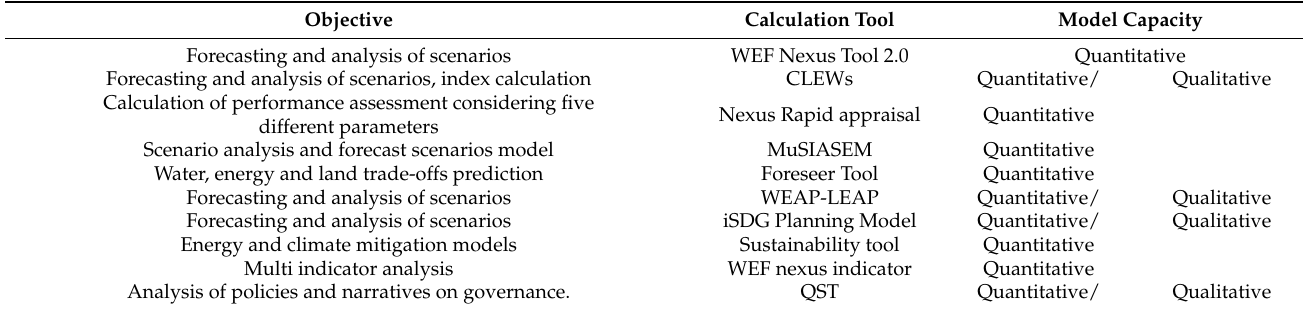
Table 3. WEF Tools performance reviewed in this research